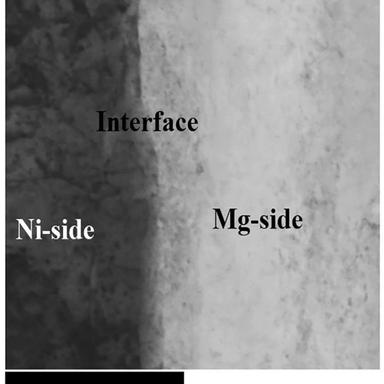
High magnification TEM image from the interface between the nickel foil layer and magnesium matrix.